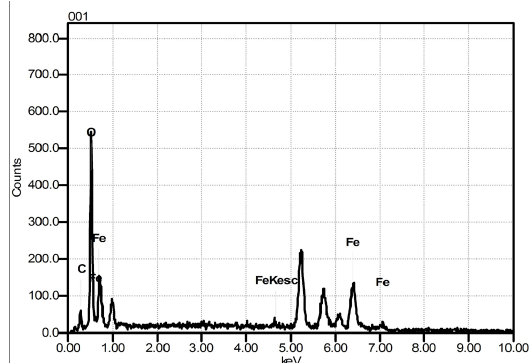
Fig. 5 Iron and carbon detected in SEM after mechanosynthesis of NdFeO